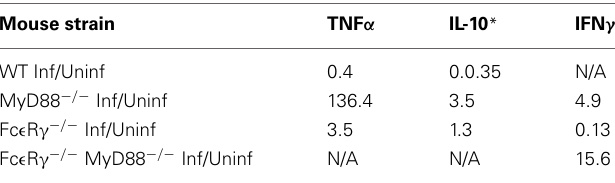
Table 4 | Detection of select cytokines by RT-PCR in 21-day infected mouse